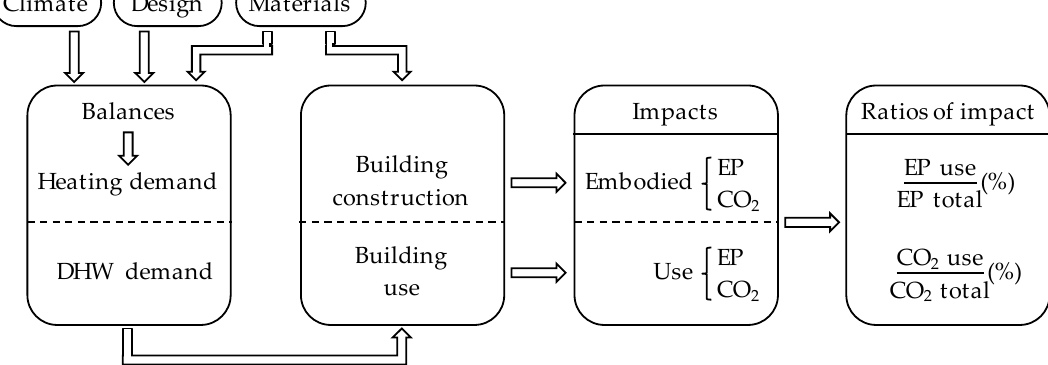
Figure 1. Flow chart of the application of the methodology.